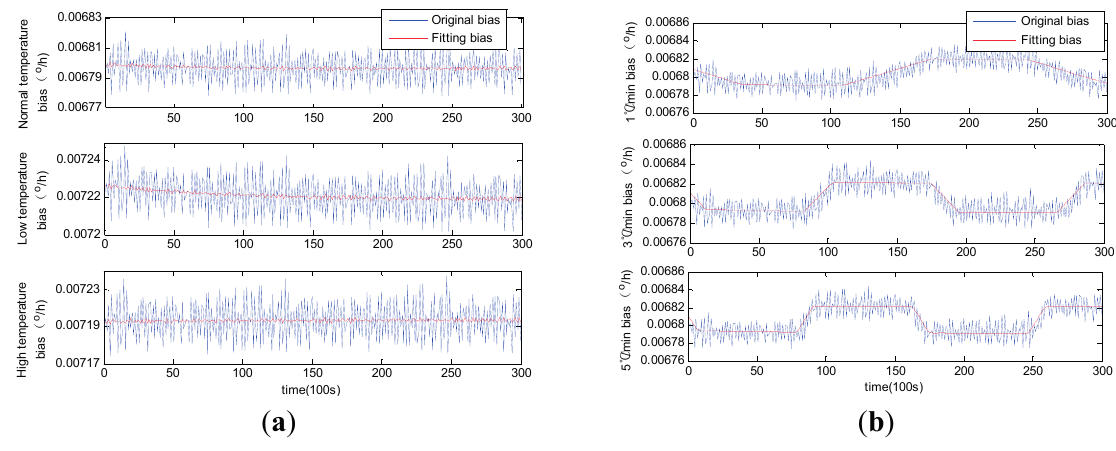
Figure 6. Forecasting curves using multiple linear regression (MLR): ( a ) constant temperature; ( b ) variable temperature.